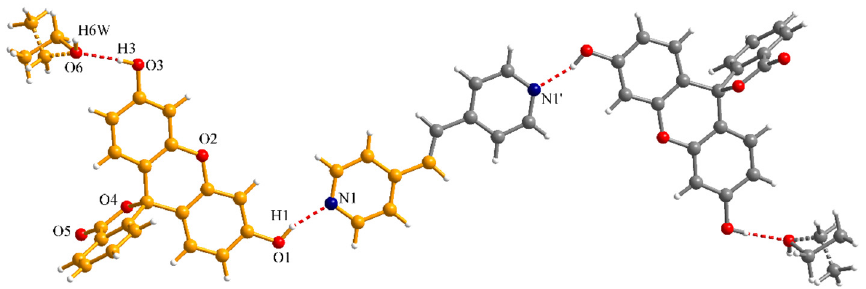
Figure 6. Crystal structure of 3 . The asymmetric unit is depicted in orange. Symmetry code: ’ = 2 − x, 3 − y, 2 − z.